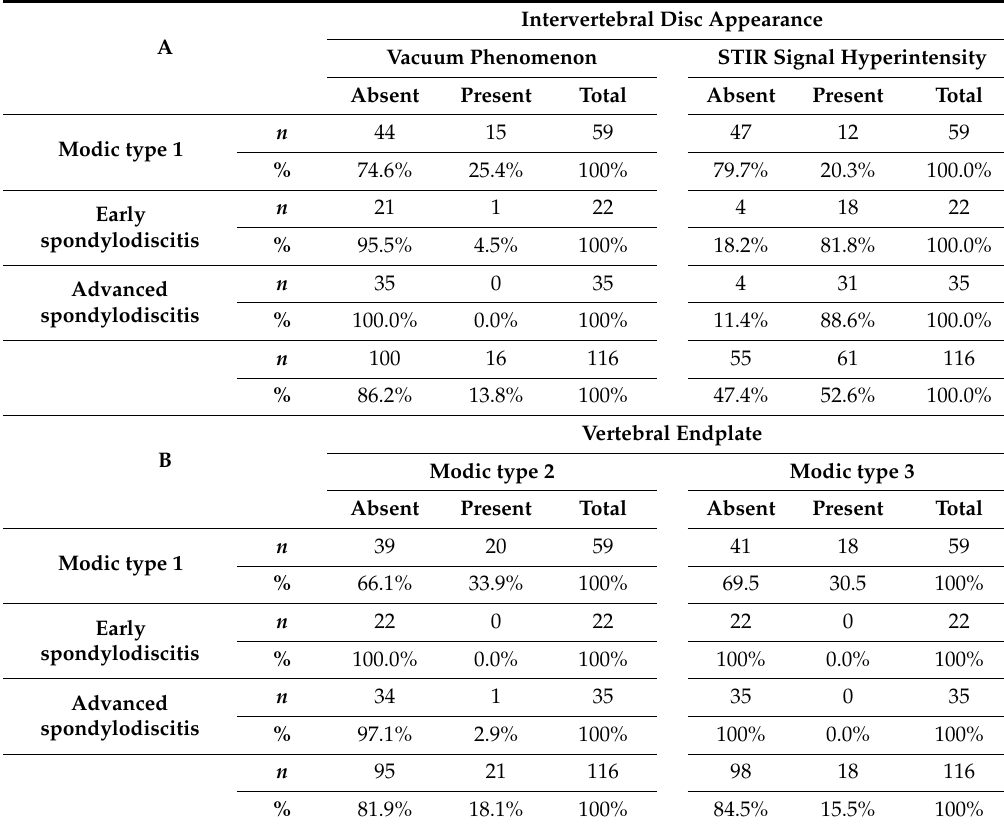
Table 7. Intervertebral disc vacuum phenomenon and discal STIR signal hyperintensity (section A). Additional Modic type 2 and 3 changes (Section